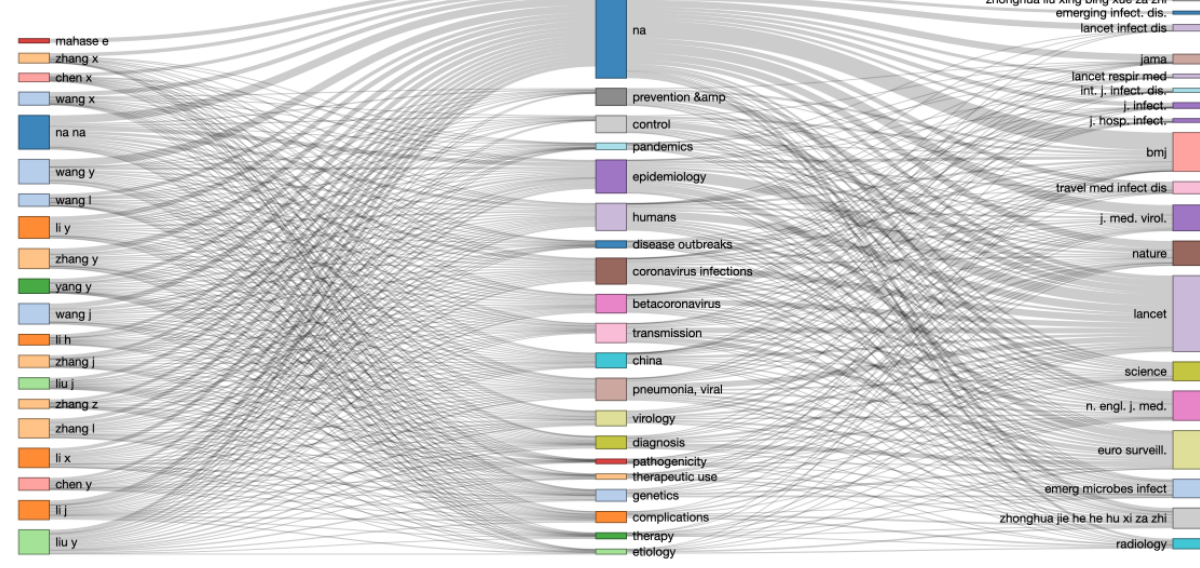
Figure 3. Country collaboration network.